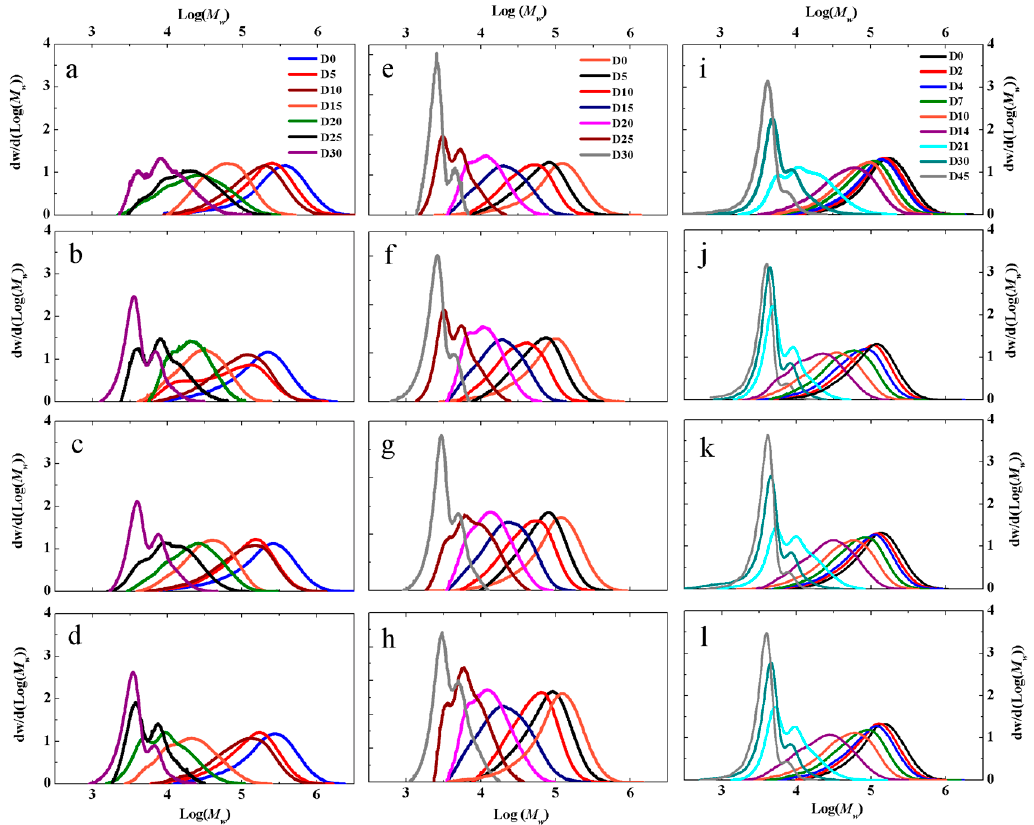
Figure 2. Change in molecular weight of ( a ) PLA, ( b ) PLA QAC, ( c ) PLA MMT and ( d ) PLA OMMT films in inoculated vermiculite media, ( e ) PLA, ( f ) PLA QAC, ( g ) PLA MMT and ( h ) PLA OMMT films in non-inoculated vermiculite media and ( i ) PLA, ( j ) PLA QAC, ( k ) PLA MMT and ( l ) PLA OMMT in water.